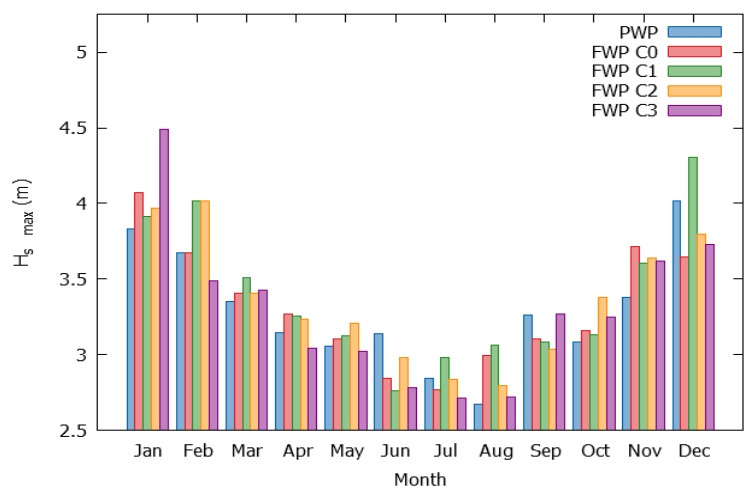
Figure 11. Comparison of present (PWP) and future (FWP-C0–C3) averaged monthly maximum storm wave height 𝐻 𝑠 max at West Gabbard.